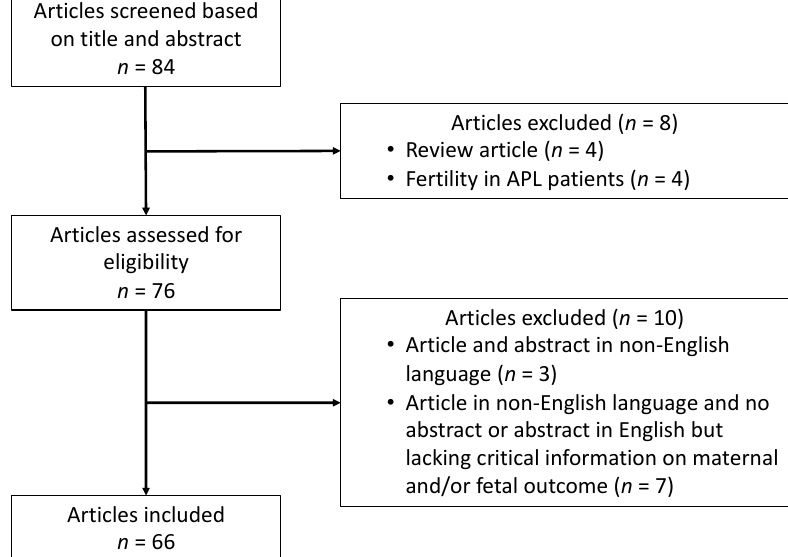
Figure 1. Flowchart of study selection process.